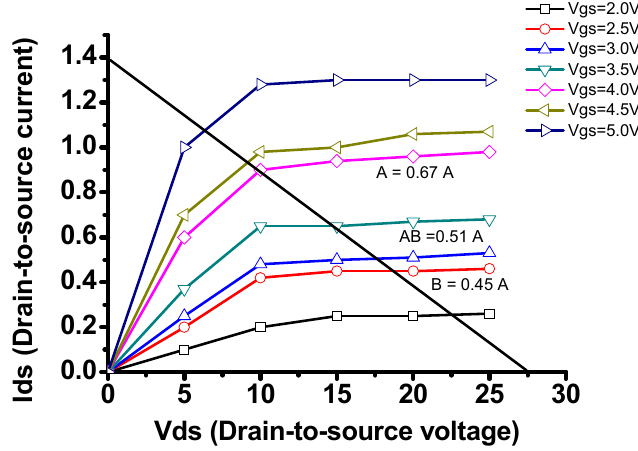
Figure 5. DC analysis points.